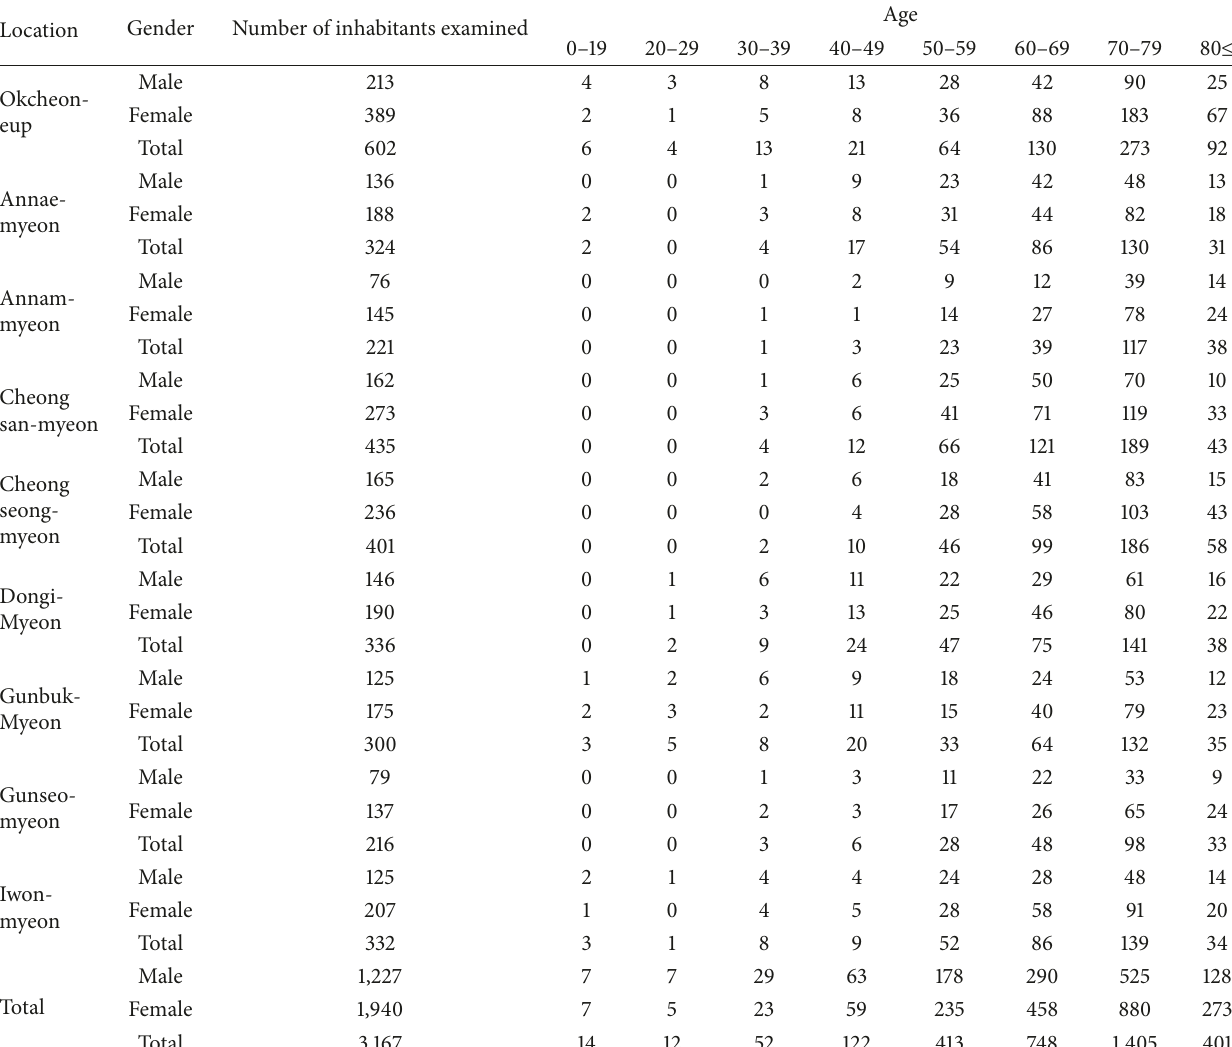
Table 1: Distribution of the